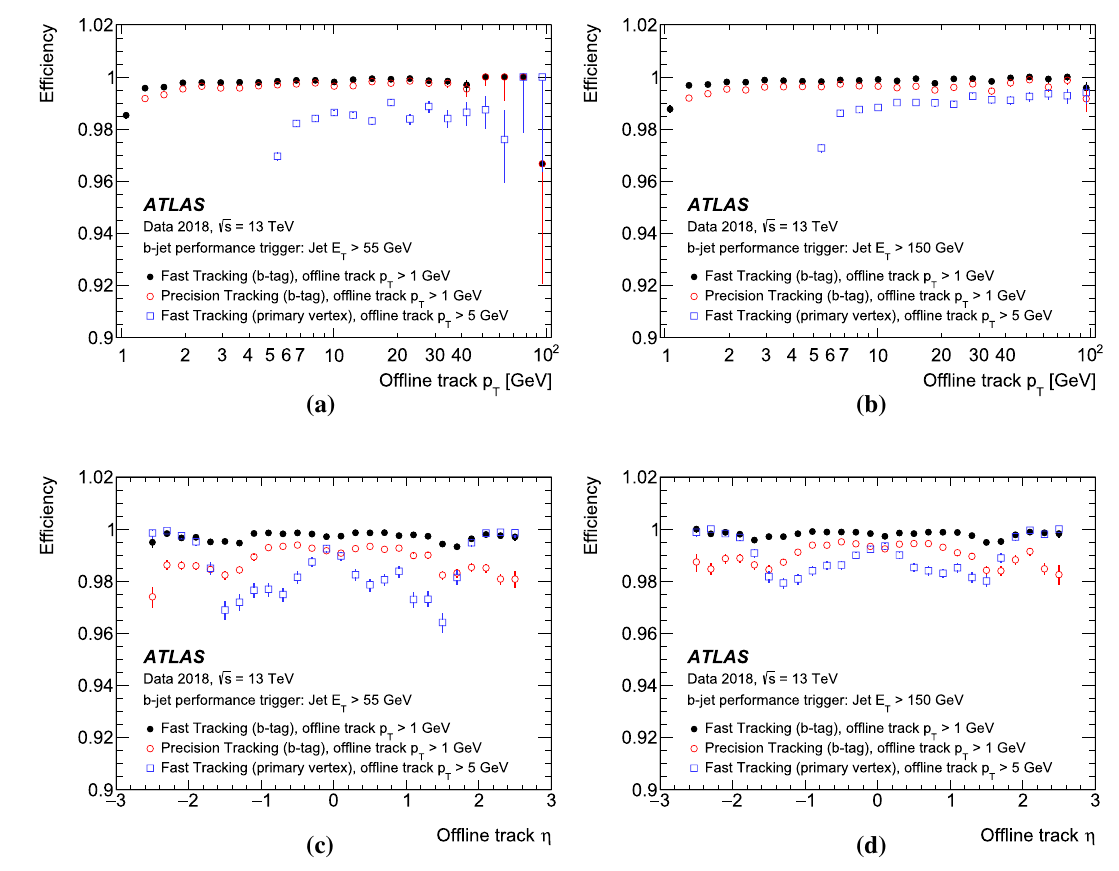
Fig. 5 Efficiency of the tracking algorithms used by the b -jet trigger, as a function of offline track p T (top) and η (bottom), for data taken during 2018 using b -jet performance triggers with a jet E T threshold of 55 GeV (left) and 150GeV (right). The Precision Tracking efficiency